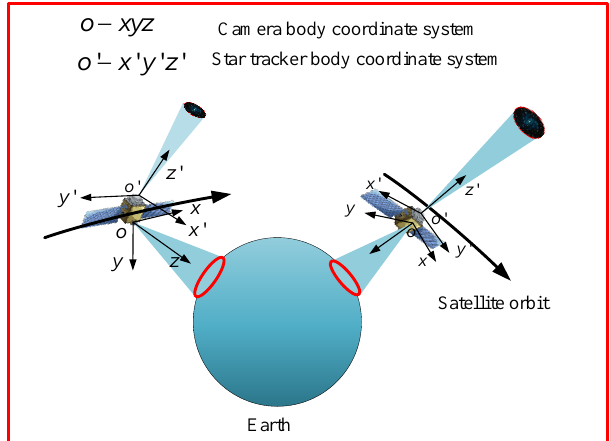
Figure 3. Schematic diagram of the proposed installation direction. Substituting